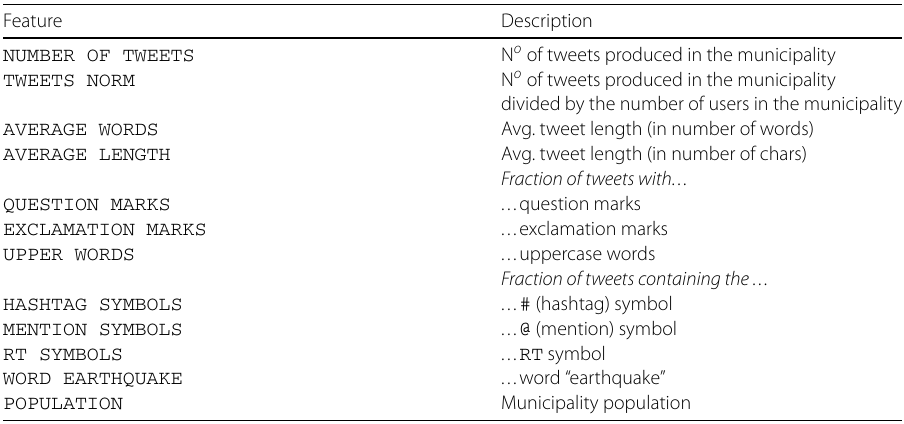
Table 1 Municipality-level features per event. The first eleven features are calculated over the set of tweets that correspond to a specific municipality. The last feature corresponds to the